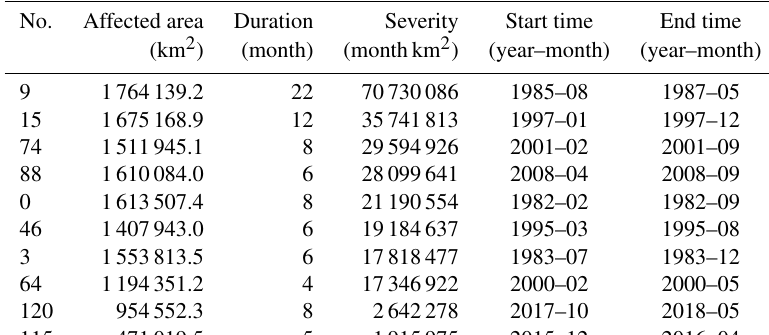
Table 2. Top 10 meteorological drought events according to severity.